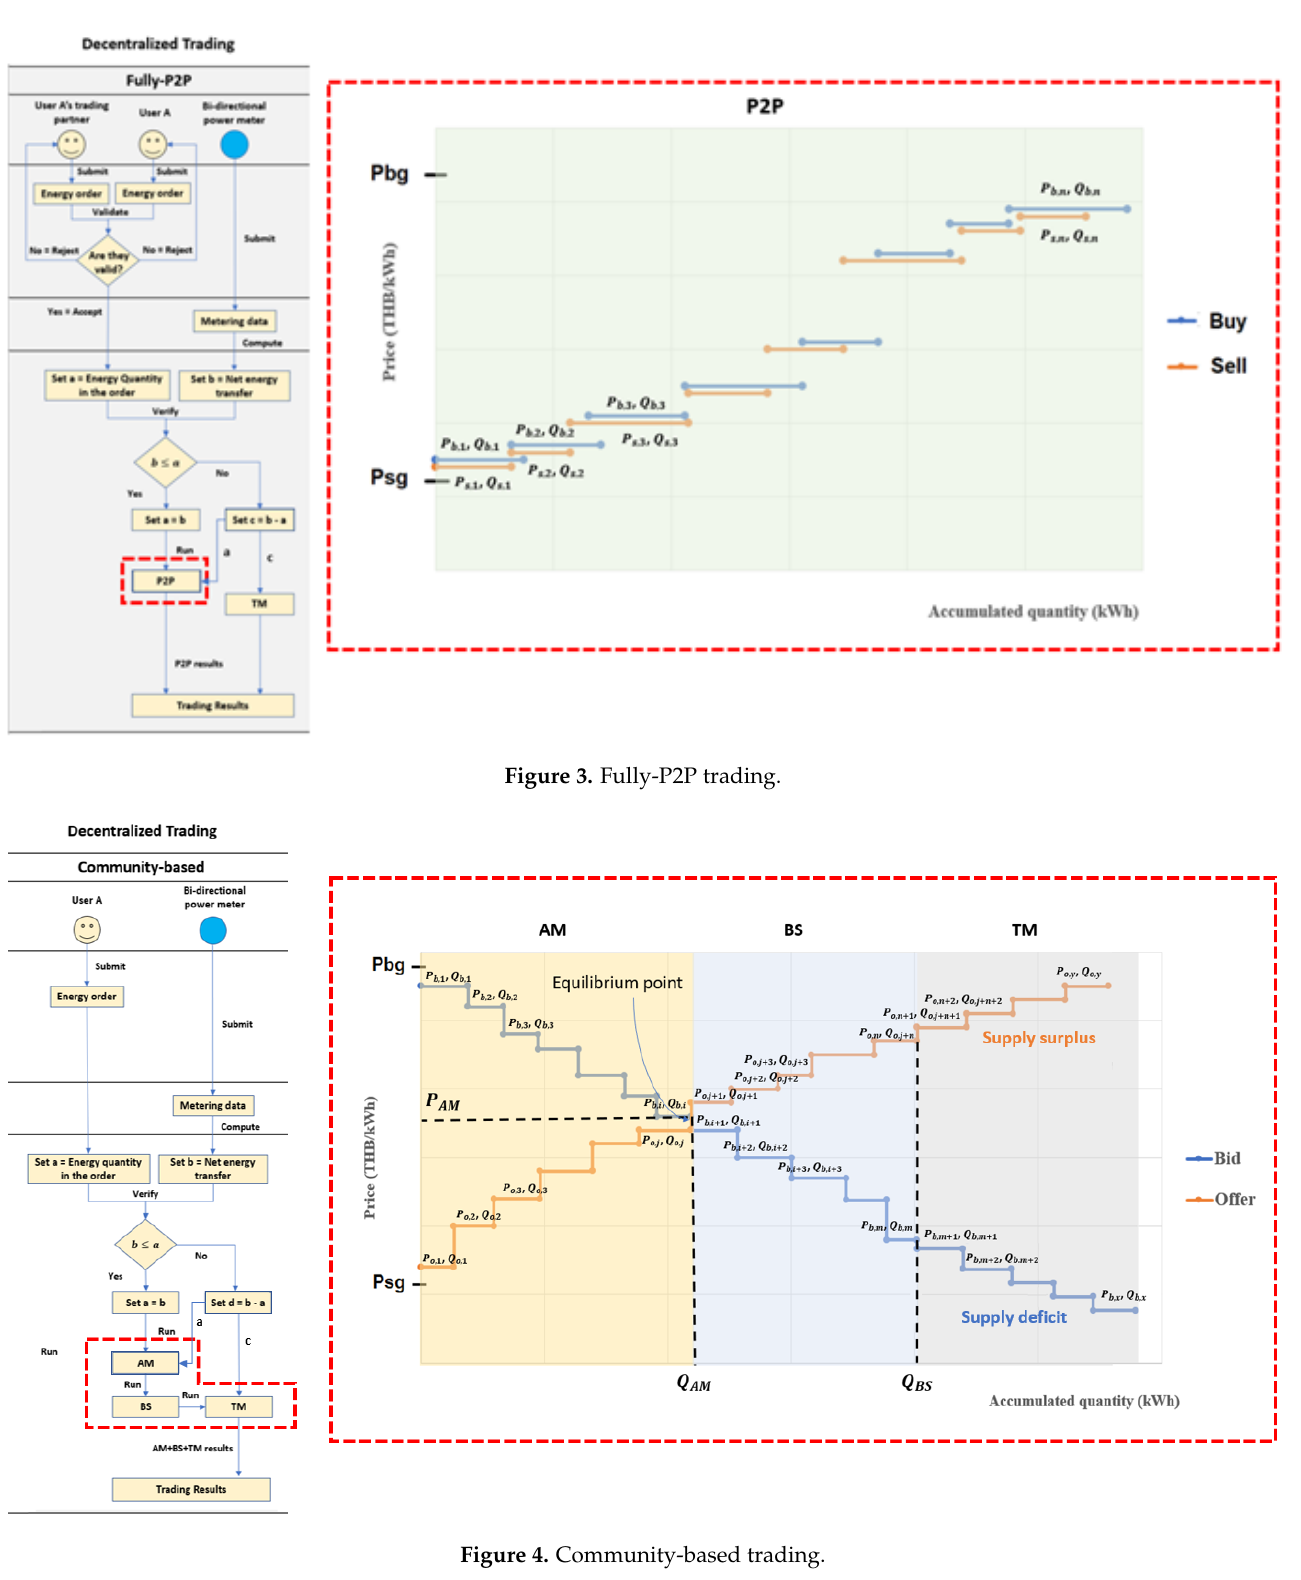
Figure 4. Community-based trading.